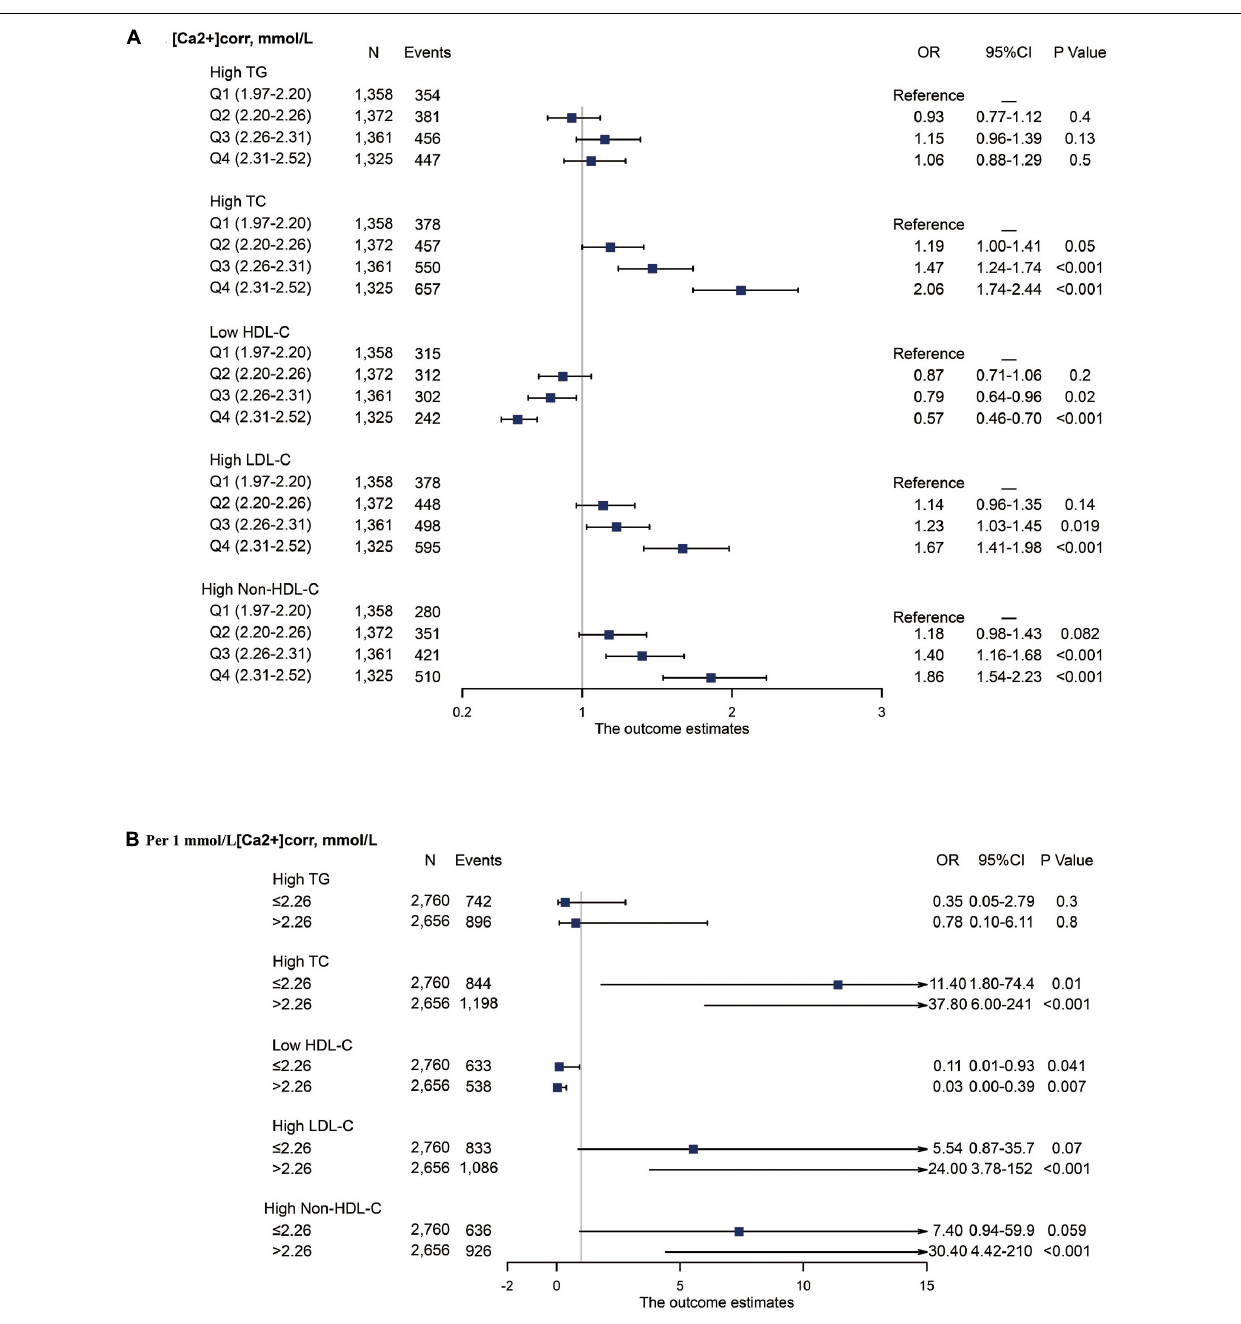
FIGURE 3 | Forest plot of serum lipid disorder odds associated with [Ca2+]corr categories. All analyses were multivariable adjusted. (A) Odds associated with four [Ca2+]corr categories. (B) Odds associated with a 1 mmol/L [Ca2+]corr increase, stratified by an [Ca2+]corr cut-off value of 2.26 mmol/L. [Ca2+]corr, corrected serum ionized calcium; TC, total cholesterol; TG, triglyceride; HDL-C, high-density lipoprotein cholesterol; LDL-C, low-density lipoprotein cholesterol; Non-HDL-C, non-high-density lipoprotein cholesterol; OR, odds ratio; CI, confidence